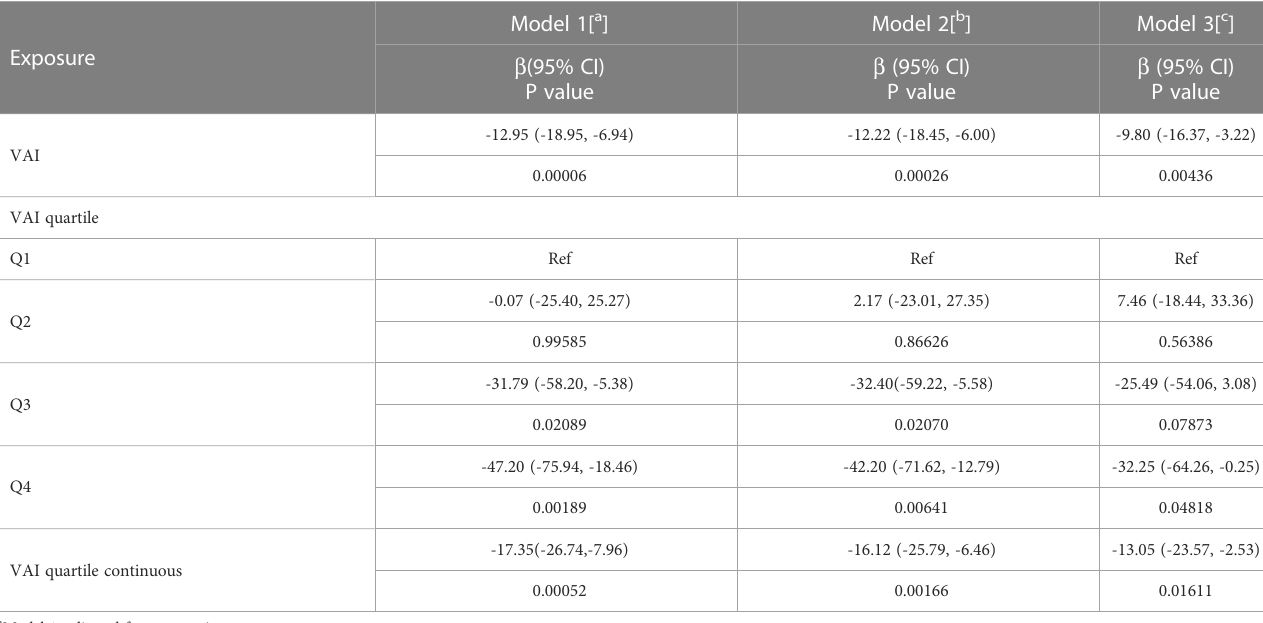
TABLE 2 Association between visceral adiposity index (VAI) and serum anti-aging protein klotho.